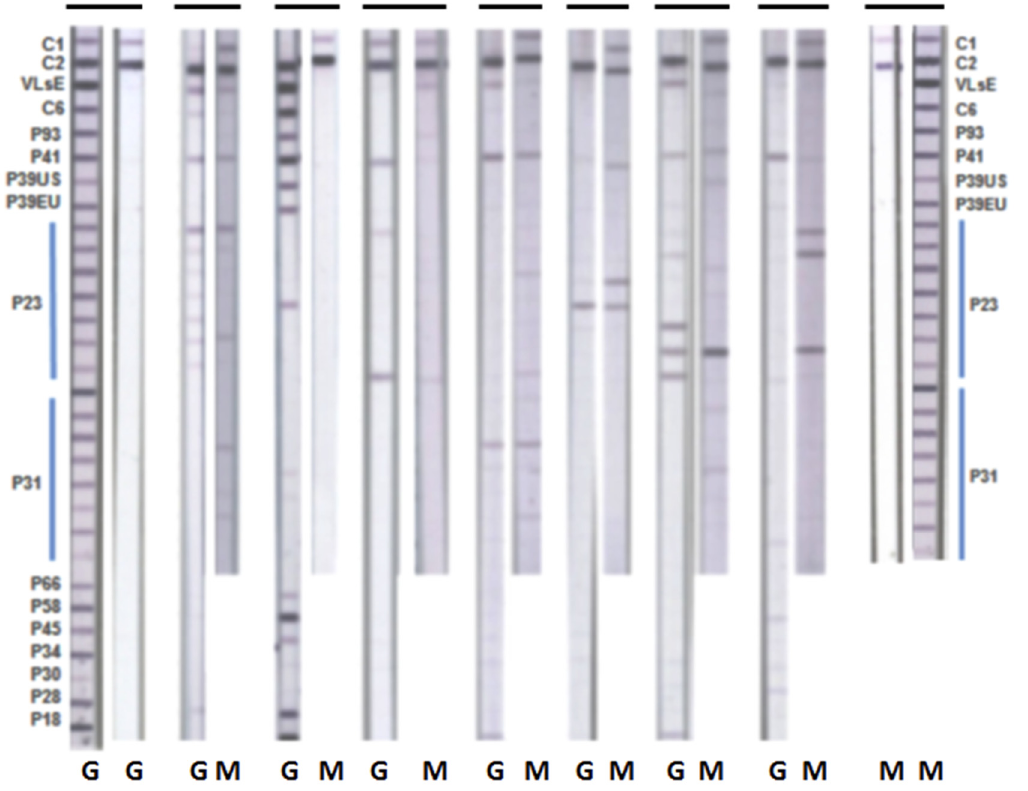
Figure A1. Immunoblot reactivity for Borrelia burgdorferi sensu lato (Bbsl). Immunoblot strips with recombinant Borrelia antigens were incubated with representative patient serum samples, as described in Section 2. Blots were interpreted according to IGeneX criteria (see text). P—positive